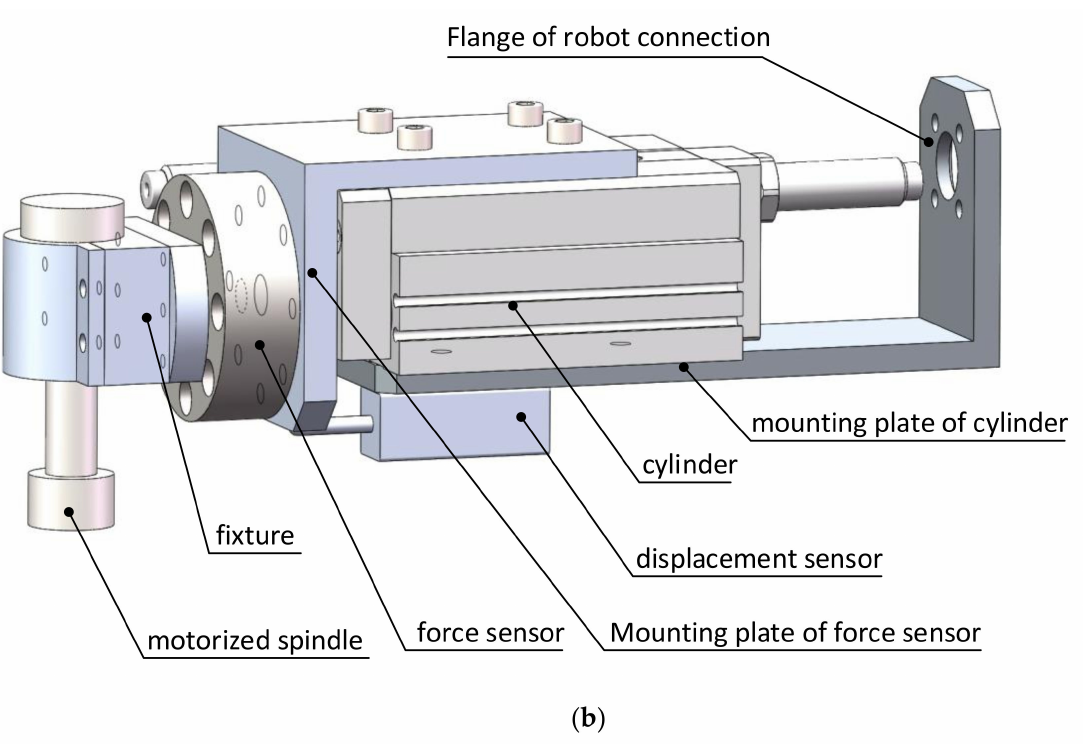
Figure 2. Three-dimensional model of the grinding system. ( a ) Layout of grinding system, ( b ) Grind- ing device.